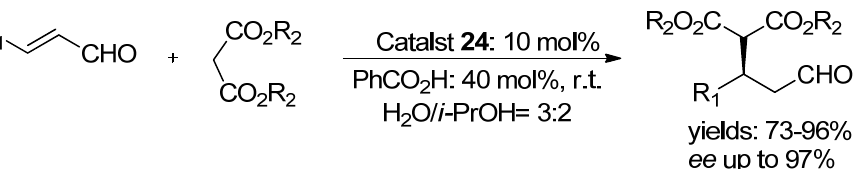
Scheme 10. Michael reaction of malonate to α , β -unsaturated